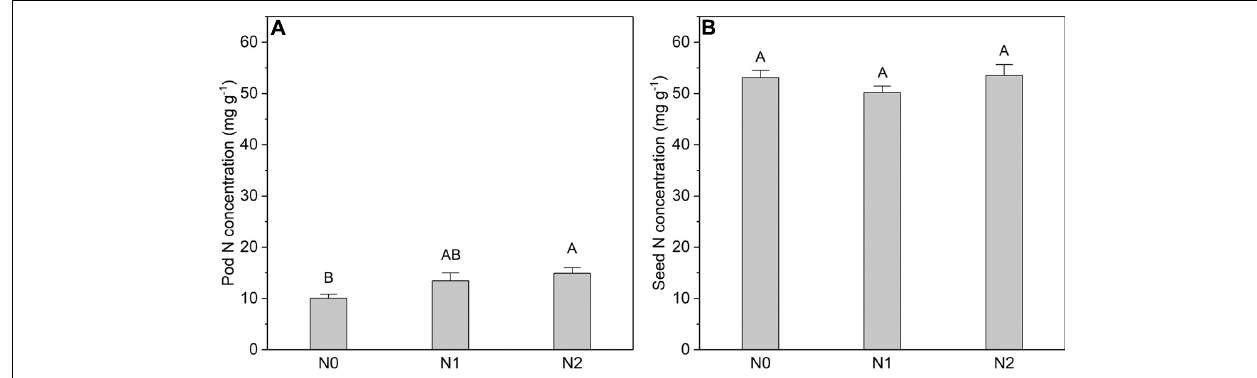
FIGURE 5 | N concentrations in (A) pods and (B) seeds at different N addition levels. Values are means ± SE. N addition ( n = 6 for each treatment): N0 (control), with no N addition; N1, 56 g N per individual; N2, 112 g N per individual. In each graph, bars labeled with different letters i.e., A, B differed significantly between treatments.